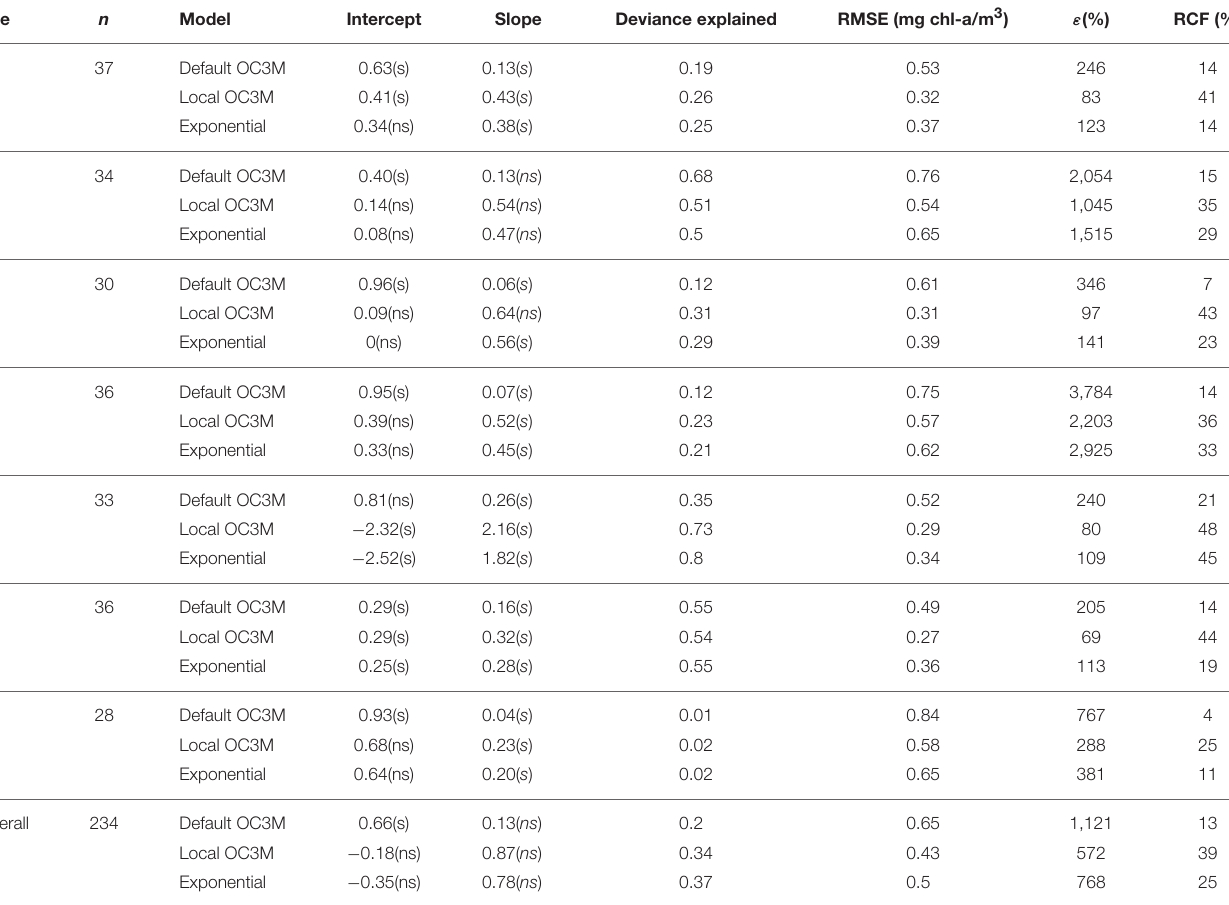
TABLE 6 | Model comparison with Hawke Bay water sample data; n = sample size and significance test results are shown in brackets. Site